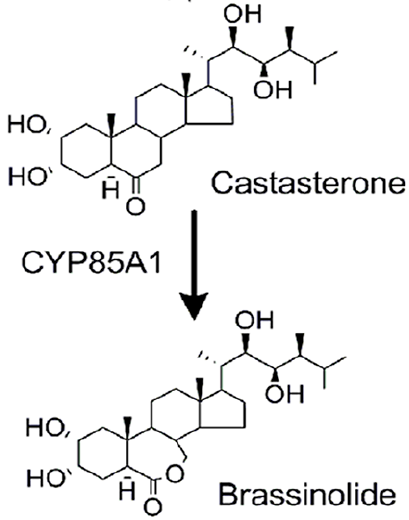
Figure 1. Role of castasterone in the synthesis of the plant hormone brassinolide.